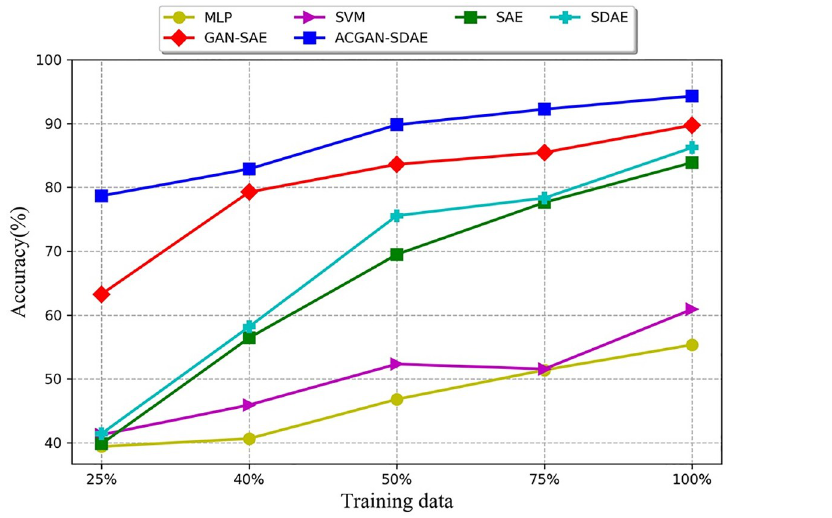
Fig 12. Diagnosis results of different models in different fault sample proportions.